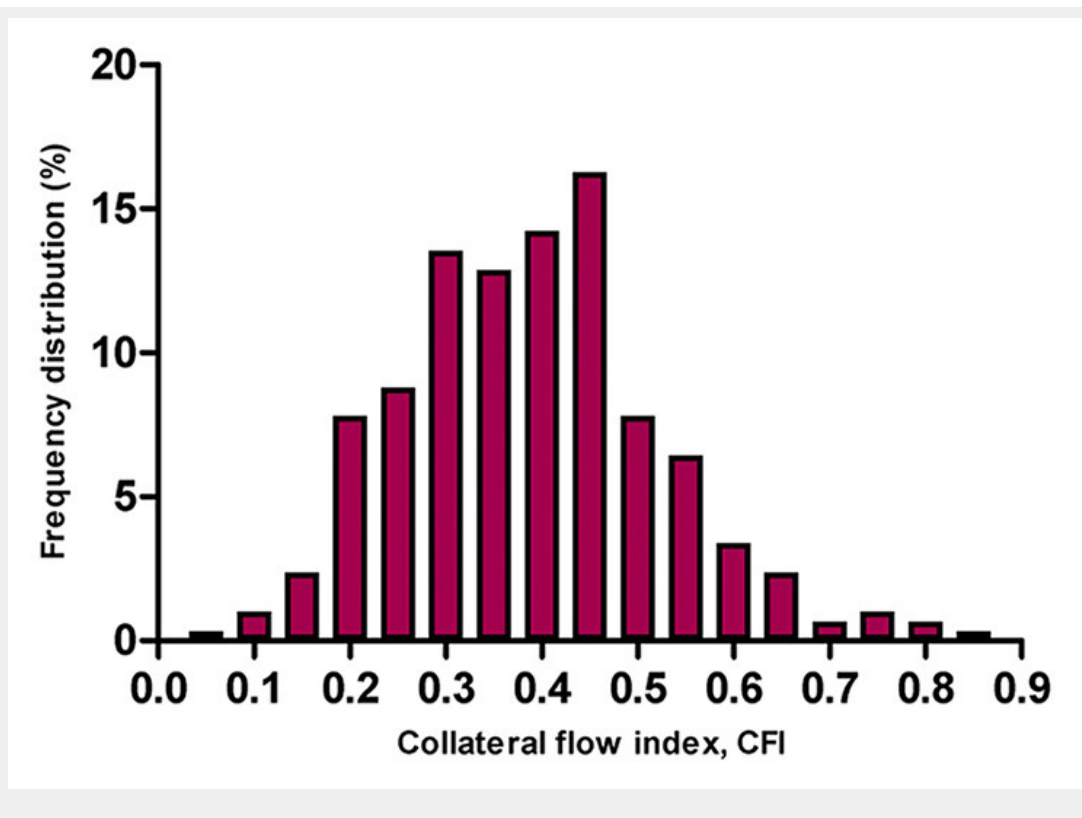
Figure 3 Frequency distribution (vertical axis in percent) of collateral flow index (CFI, horizontal axis) in 295 patients with chronic total occlusion. In this population mean CFI was 0.39 ± 0.14. (Adapted from van der Hoeven NW, et al. Clinical parameters associated with collateral development in patients with chronic total coronary occlusion. Heart. 2013;99:1100–5 [38], with permission from BMJ Publishing Group